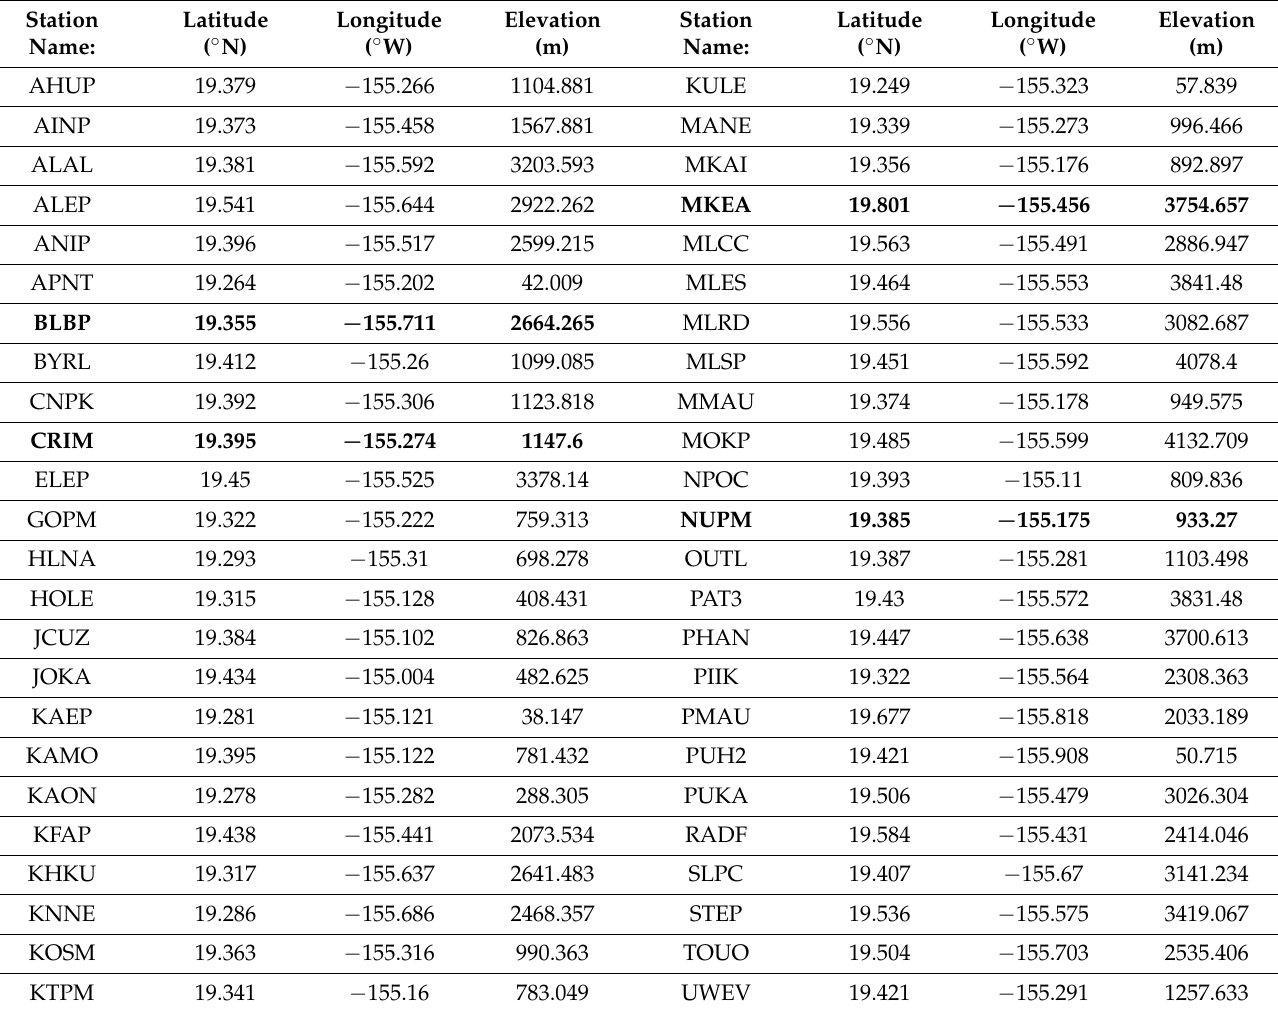
Table 1. GNSSS stations over Hawaii Island used in this study for time series integration with DInSAR data. Bolded station corresponds to colored diamonds in Figure 1. GNSS data were obtained through the NGL, and stations were maintained by the USGS HVO